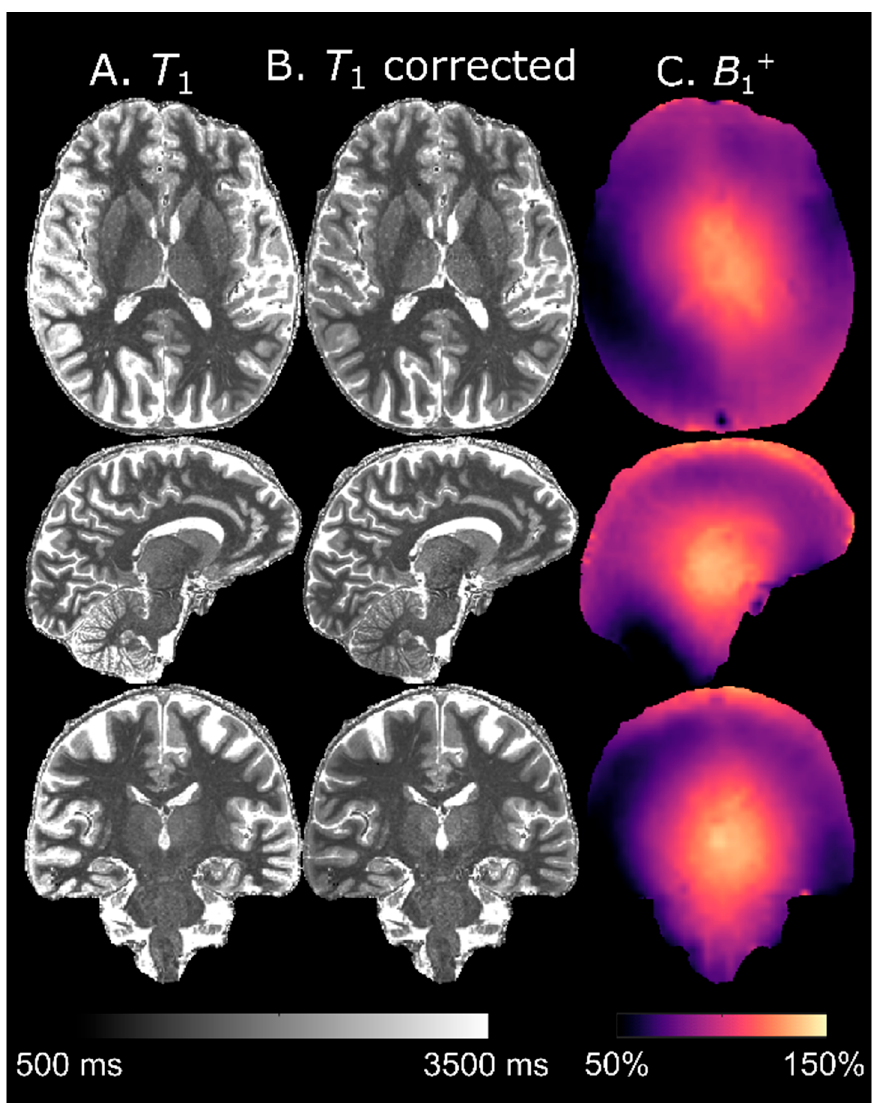
Figure 8. LUT-derived T 1 maps, uncorrected ( A ) and corrected ( B ) with a separately acquired B 1+ map ( C ). The T 1 estimation in tissue was moderately robust against B 1+ influence and mostly CSF was affected.